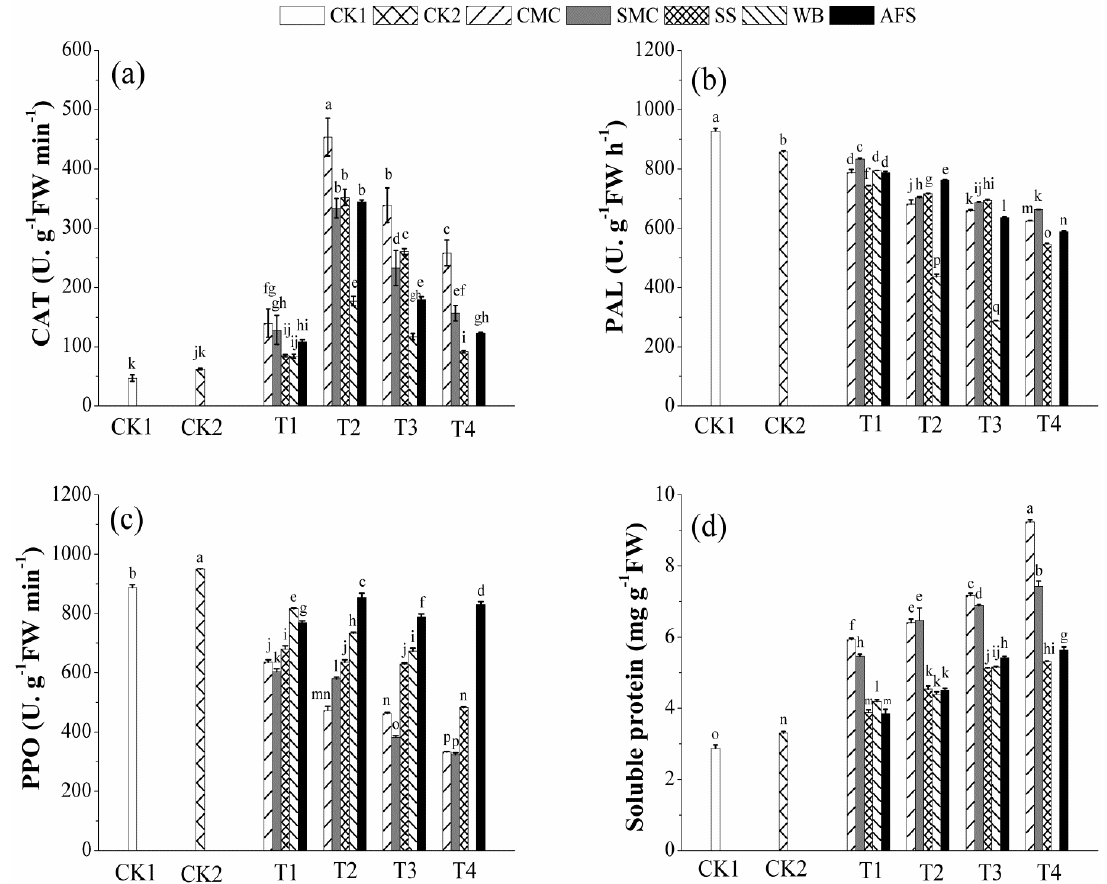
Figure 4. Effect of amendments on CAT ( a ), PAL ( b ), PPO ( c ) activities and soluble protein content ( d ) of A. fruticosa leaf. The amendment treatments are denoted as T1, T2, T3 and T4. Error bars represent the standard deviation of the mean ( n = 3). Letters above the bars refer to the difference at significance level ( p < 0.05, LSD) among different treatments. CK1: Control 1; CK2: Control 2; CMC: Cattle manure compost; SMC: Spent mushroom compost; SS: Sewage sludge; WB: Wood biochar; AFS: Agricultural field soil. Plant did not grow in WBT4.